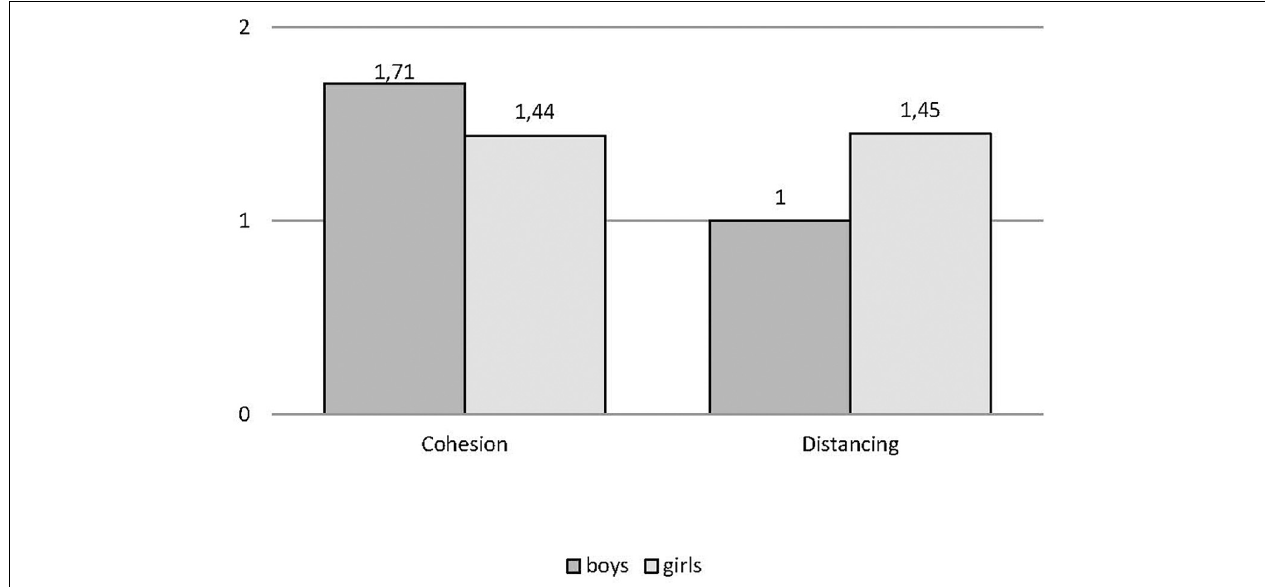
FIGURE 3 | Cohesion and distancing in distress by